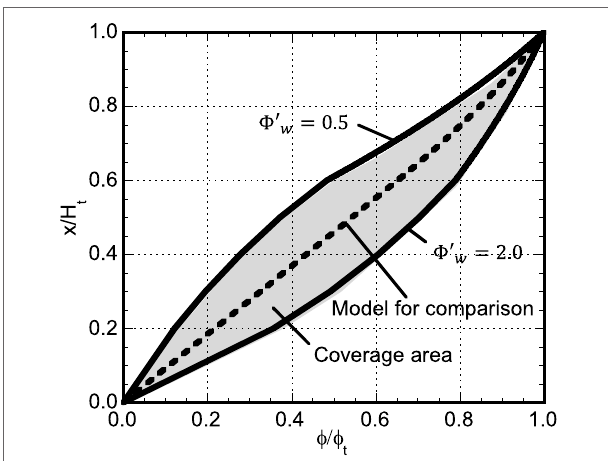
FIGURE 5 | Investigated region of fundamental-mode